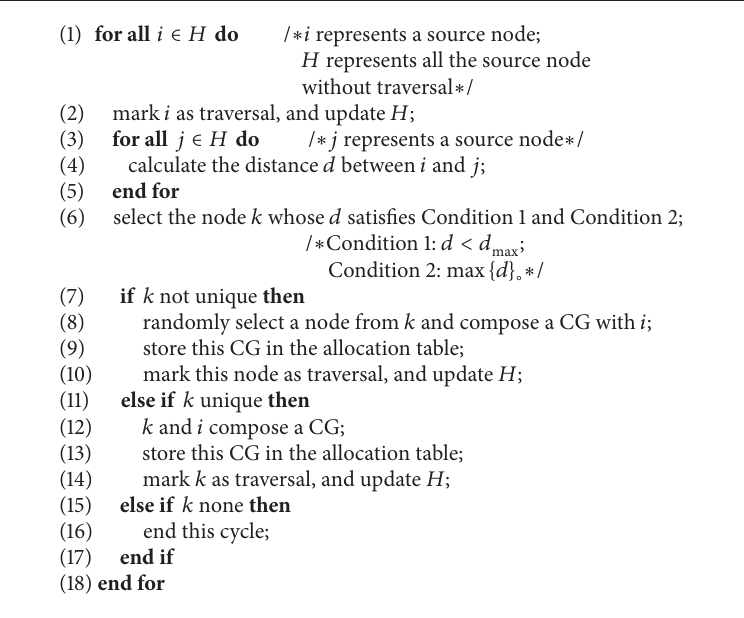
Algorithm 1: Cooperative group allocation